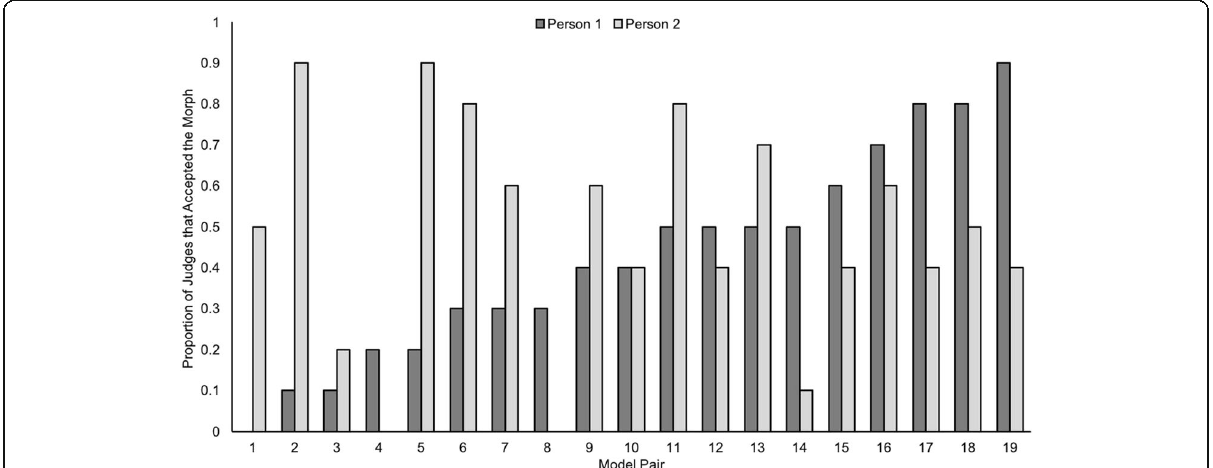
Fig. 3 Morph acceptance for 19 of the pairs in Experiment 3. Both models within each pair are shown, illustrating the acceptance of